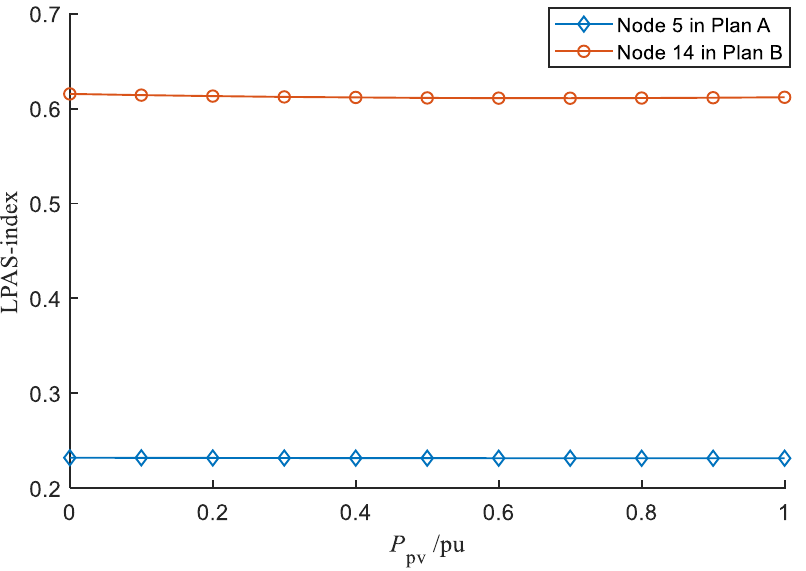
Figure 6. PV active output P pv —LPAS-index curves (Load multiple lm = 1 pu).